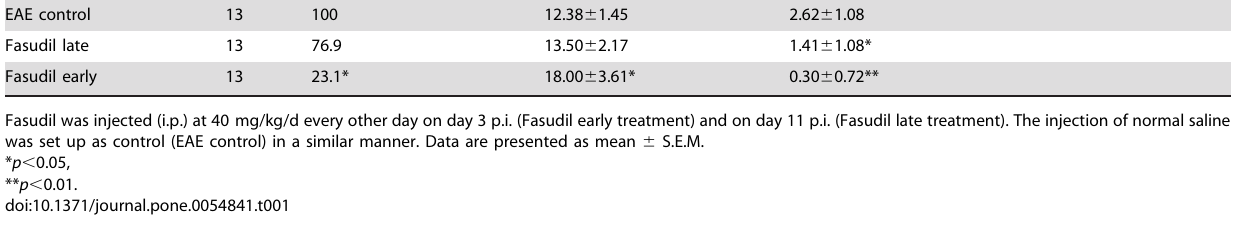
Table 1. The clinical evaluation of EAE mice.